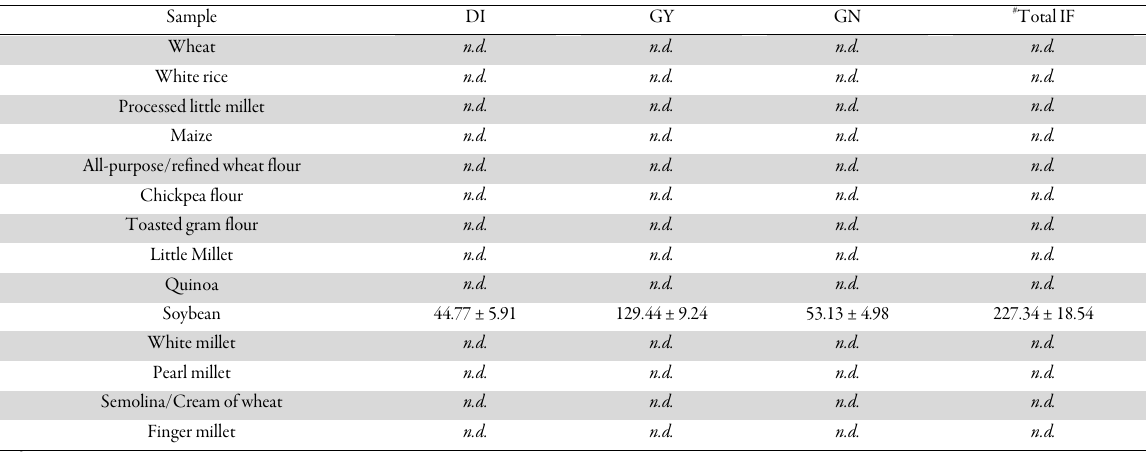
Table 2. Detection and quantification of total and individual aglycone IF contents from staple Indian grain flours Sample